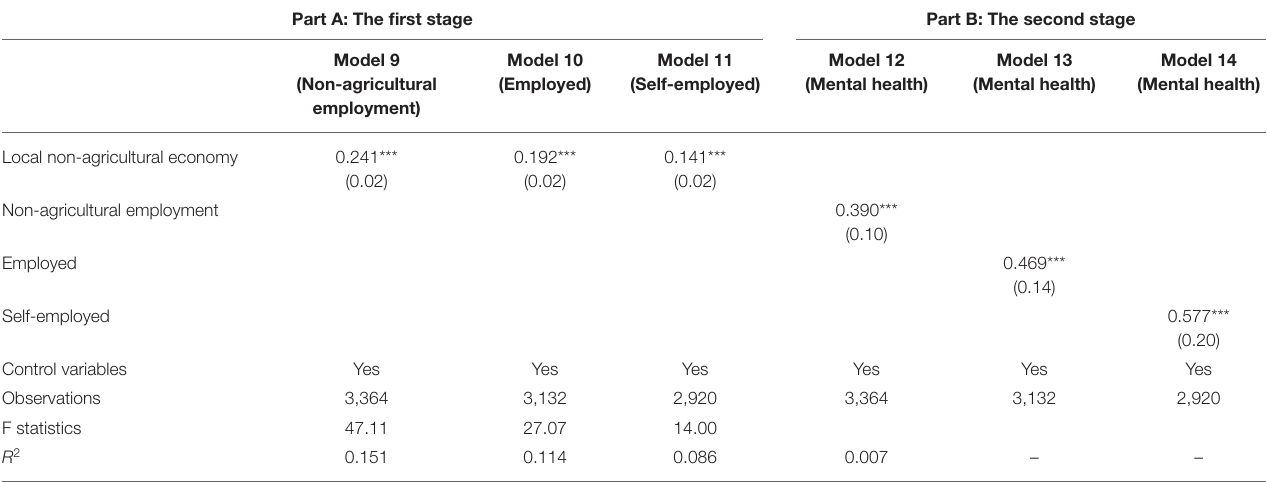
TABLE 4 | Instrumental variable method: